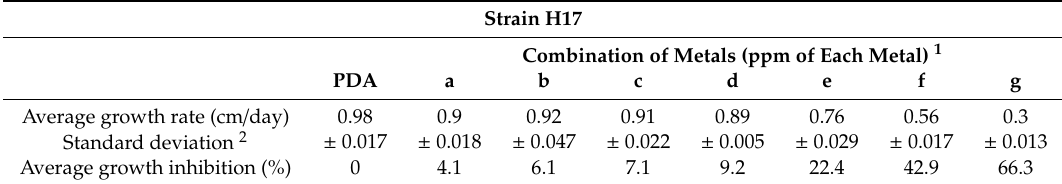
1 Combination of metals: detailed in Supplementary Table S1. ( a ) Cu (100), Zn (250), and Pb (300); ( b ) Cu (200), Zn (350), and Pb (400); ( c ) Cu (300), Zn (500), and Pb (500); ( d ) Cu (500), Zn (700), and Pb (600); ( e ) Cu (600), Zn (800), and Pb (700); ( f ) Cu (700), Zn (1000), and Pb (1000 ppm); ( g ) Cu (1000), Zn (1400), and Pb (1400). 2 Refers to the growth rate. All treatments were tested in